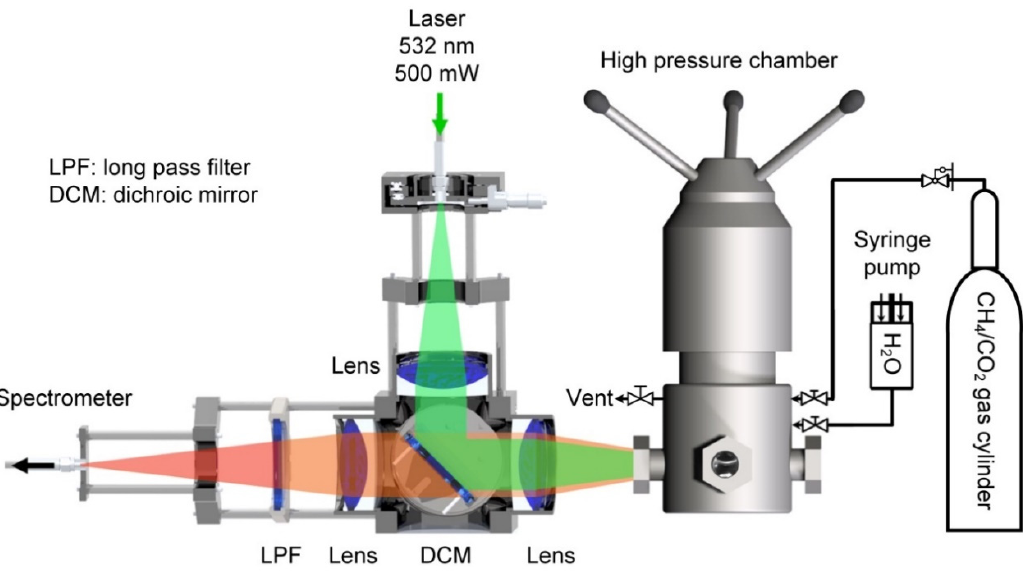
Figure 1. Sketch of the experimental setup, including the high pressure view cell.